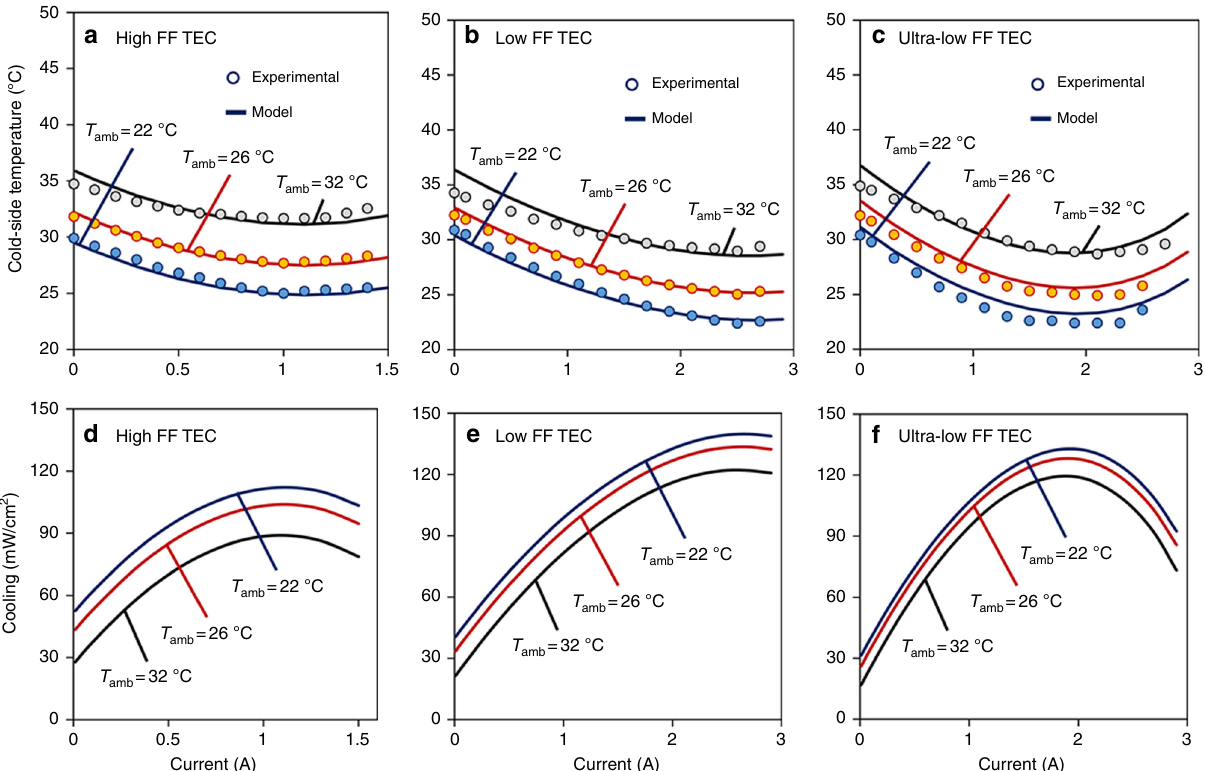
Fig. 8 Cold-side temperature and cooling for TECs on human body. Increase in ambient temperature negatively impacts the cooling performance of the TECs. a – c In a hot climate (ambient temperature ~32 °C), the high-FF TEC is unable to cool the skin temperature to its normal temperature (~30.5 °C), whereas the low- and ultra-low FF TECs are effective even in extreme climate. d – f The numerical results illustrating cooling fl ux versus electric current for different FF TECs deployed on human body under different ambient temperatures. The cooling fl ux increases with increase in electric current, but it decreases with increases in ambient temperature. Circles illustrate the experimental data whereas solid lines show the modeling results